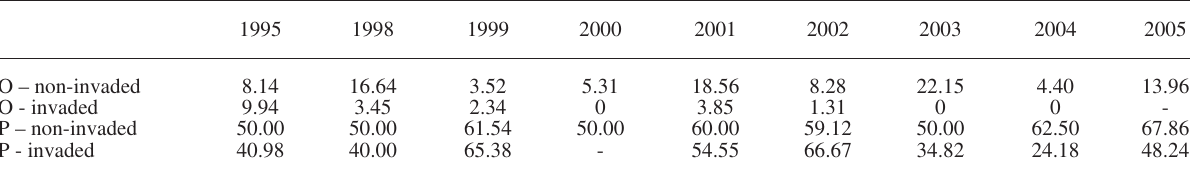
Table 2. – Proportion (%) of the total number of ramifications measured on orthotropic (o) and plagiotropic (P) shoots / total number of orthotropic shoots of Posidonia oceanica measured at the invaded site by Caulerpa taxifolia of Cap Martin and at the non-invaded reference site of Cap d’antibes from 1995 to 2005; - : absence of